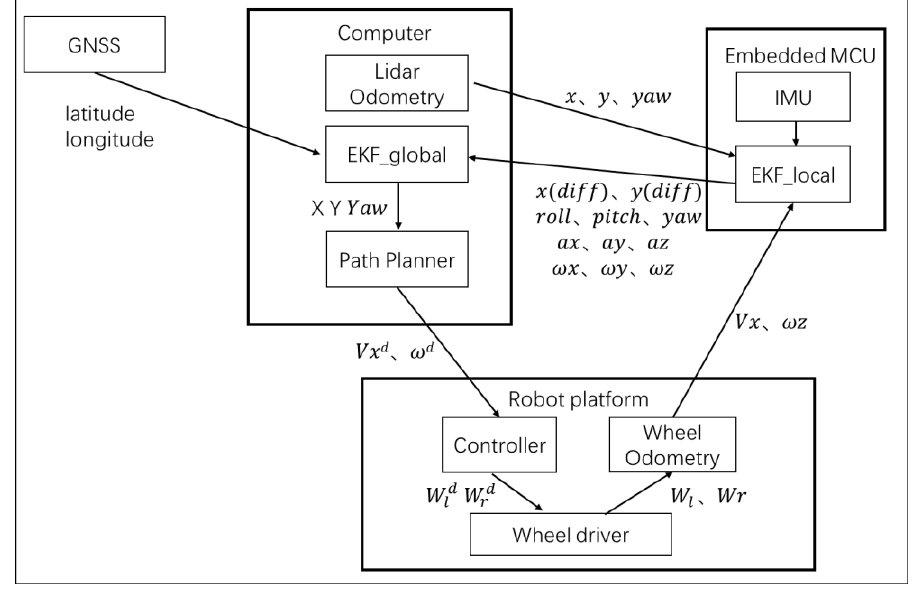
Figure 9. Fusion localization structure diagram.